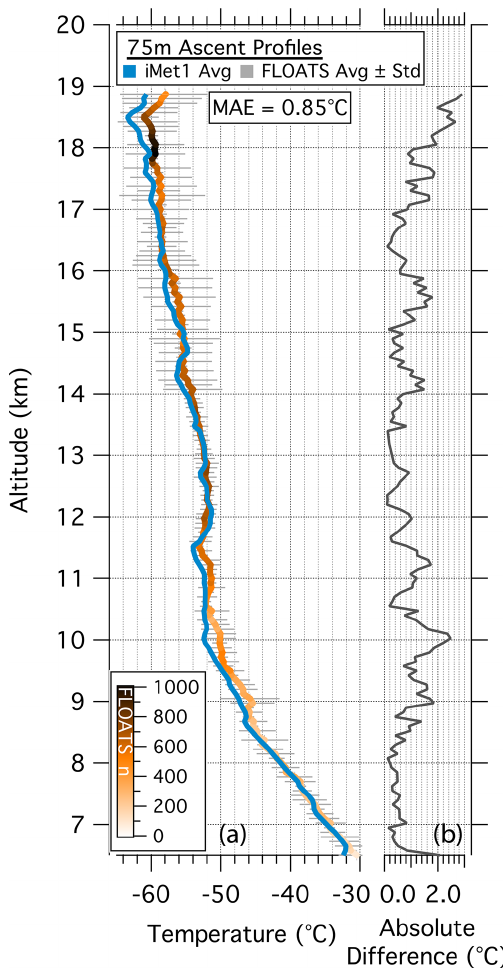
Figure 4. (a) Ascent temperature profiles of the gondola-level iMet radiosonde (blue line) and the DTS scans averaged into 75m bins. The DTS average temperature (orange gradient) is colored by the number ( n ) of 1m DTS sample points averaged for each 75m bin. The standard deviation of the 75m DTS bins is shown in